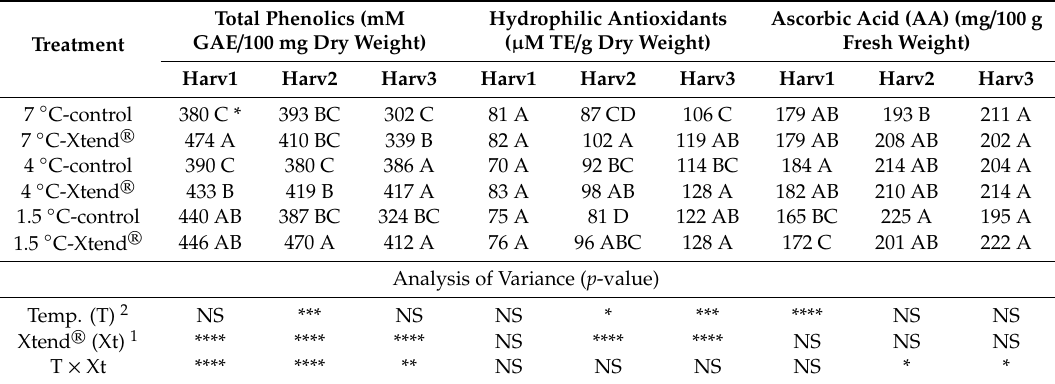
Table 3. E ff ects of cold treatments on the total phenolic content (mM GAE / 100 mg dry weight), hydrophilic antioxidant content ( µ M TE / g dry weight) and ascorbic acid (AA) content (mg / 100 g fresh weight) of yellow peppers, cv. Dinamo, after 21 days of storage at di ff erent low temperatures, followed by 3 days of storage at 21 ◦ C.